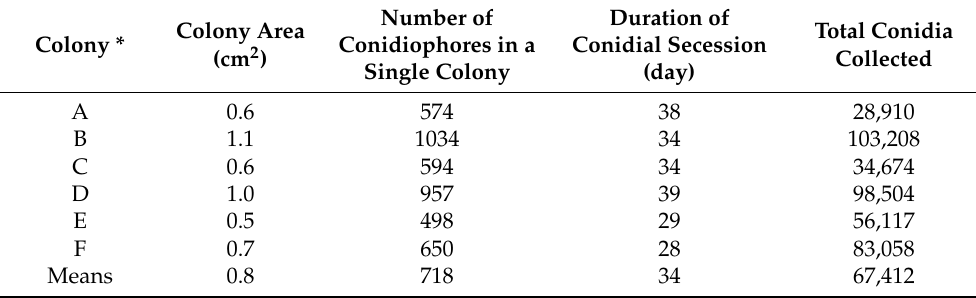
Table 1. Development of individual colonies of Podosphaera aphanis KSP-7N on leaves of strawberry seedlings during the period of conidiation by conidiophores, assessed by direct counting of progeny conidia consecutively trapped on insulator films electrostatically